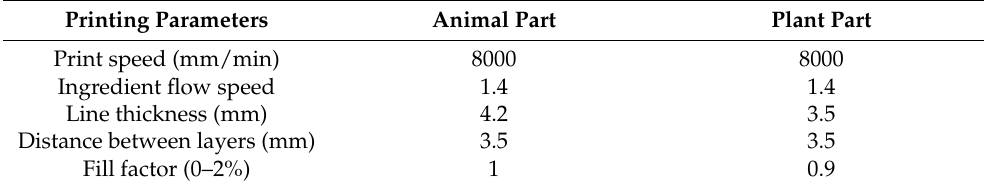
Table 2. Calibrated printing parameters used for the animal and plant mixtures.